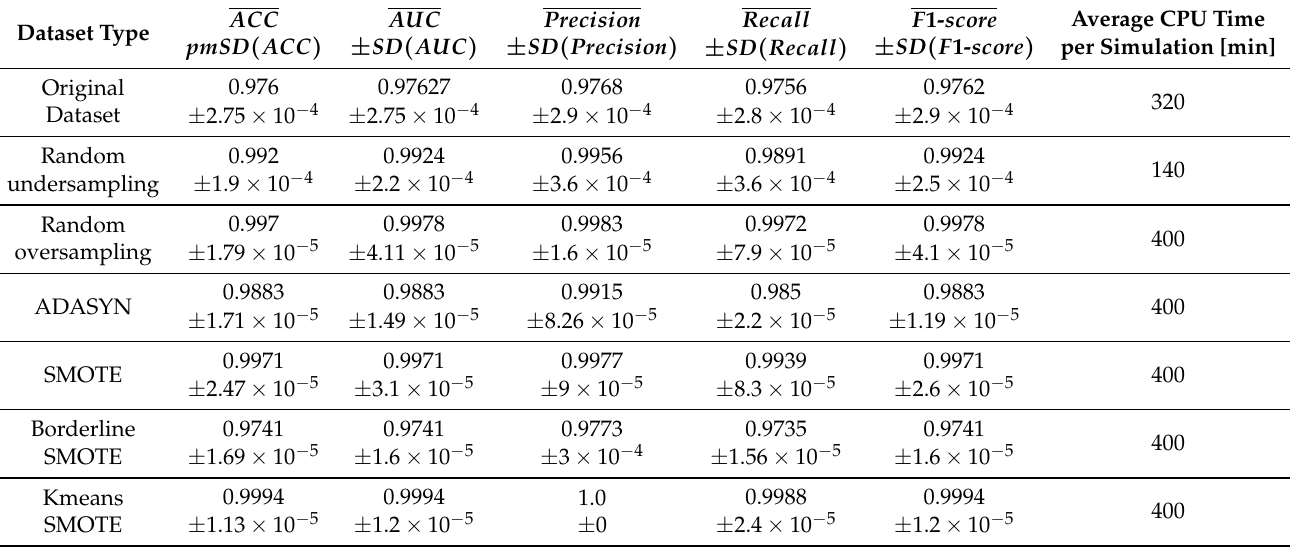
Table 11. The mean and standard deviation of evaluation metric values used in GPSC with random hyperparameter search with 5-fold